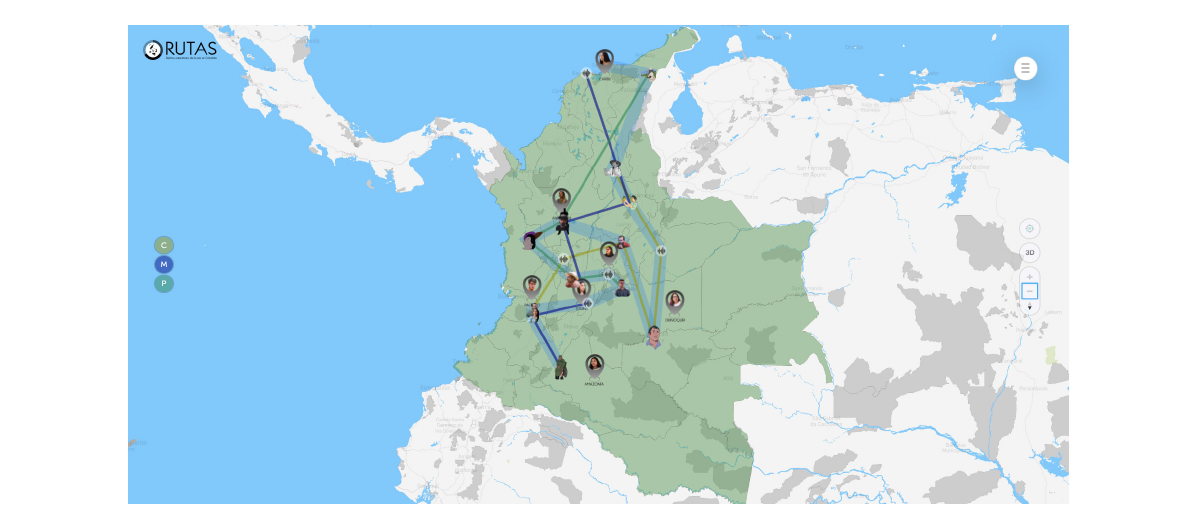
FIGURE3 The initial view of the platform. Interactions routes: Armed Conflict, Memory of the Victims, Peace Process. Source: RUTAS platform.